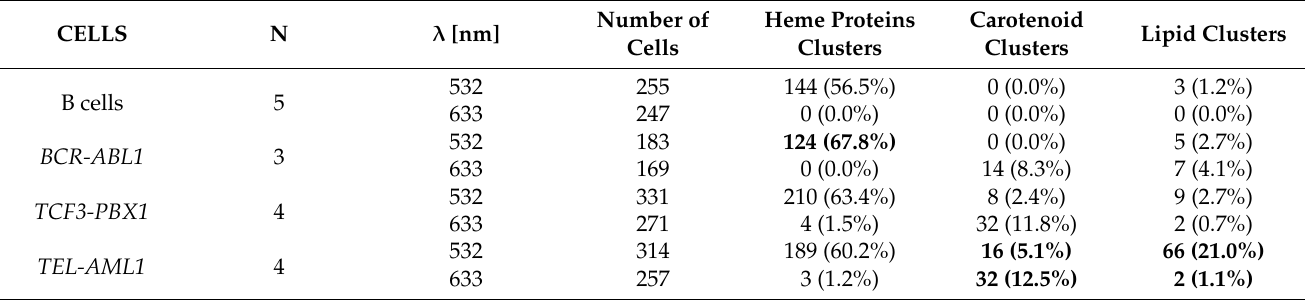
Table 2. A summary of measurements using two lasers ( λ = 532 nm and λ = 633 nm), including the number of donors (N), number of measured cells, and percentage of cells with heme proteins, carotenoids, and lipid clusters recognized by KMC. The values representing the most abundant cluster within the analyzed cells are in